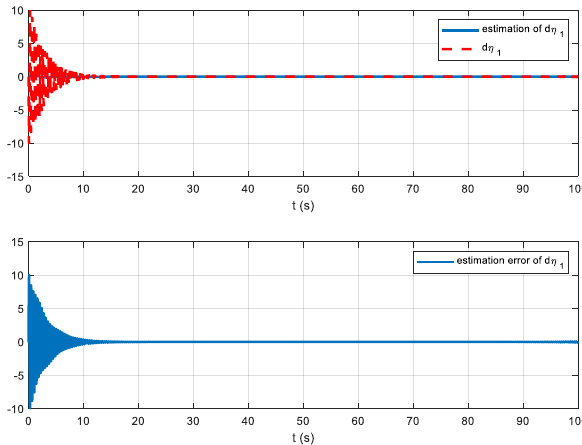
Figure 5. η 2 and its estimation. Figure 5. 2  and its estimation. Figure 5. 2  and its estimation.